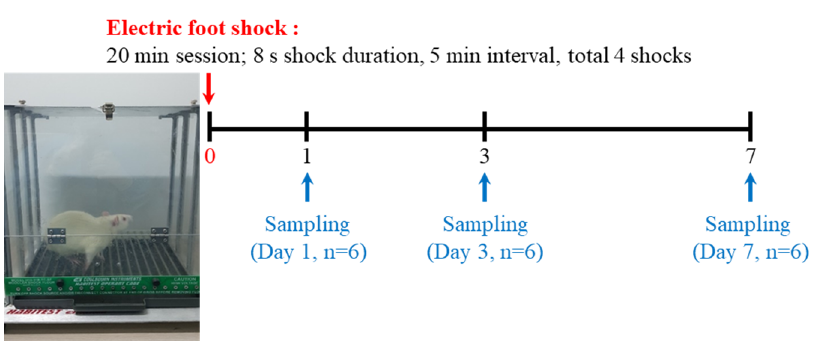
Figure 8. Study design for the induction of acute severe stress. After acute severe stress was induced using electric foot shock, groups were sacrificed at 1 day, 3 days, or 7 days after stress exposure.